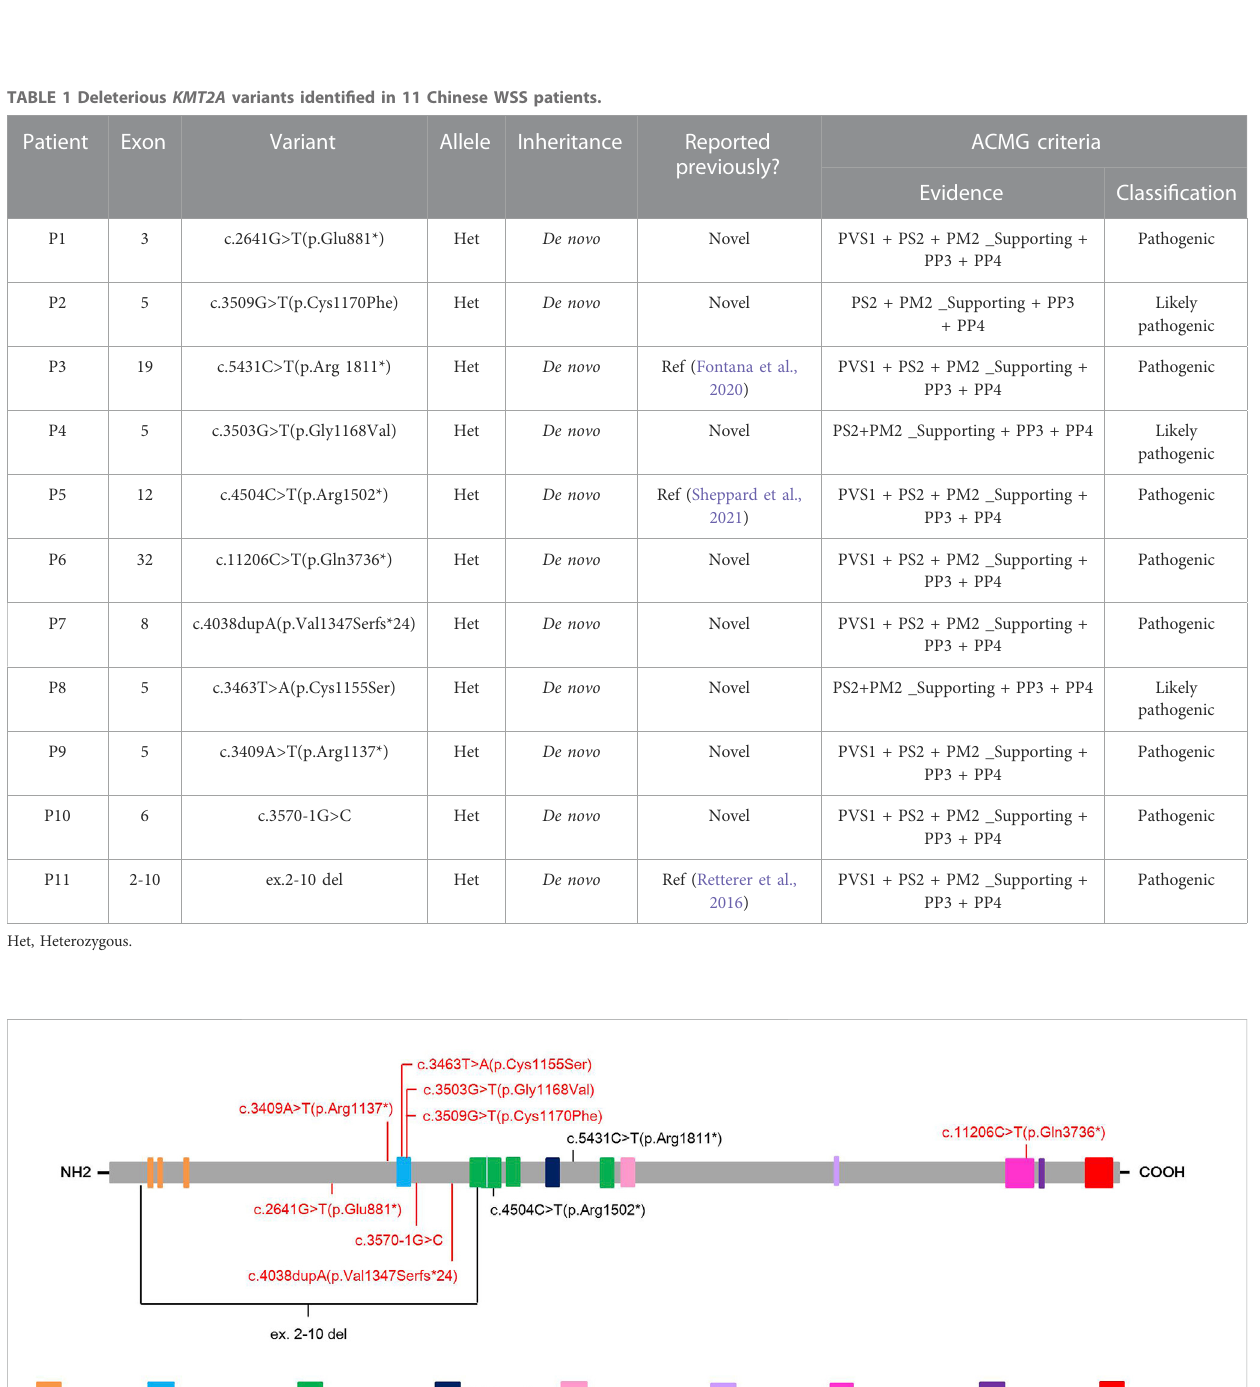
(Supplementary Table S1). The GH peak level and IGF-1 level of